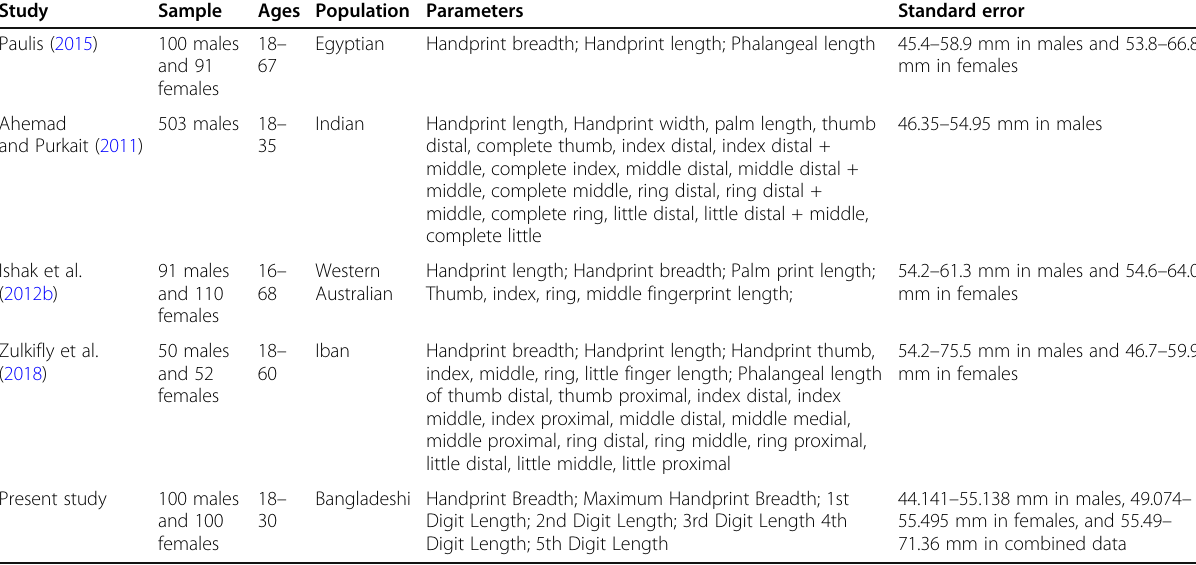
Table 7 Comparison of studies dealing with the stature estimation from the hand measurements using linear